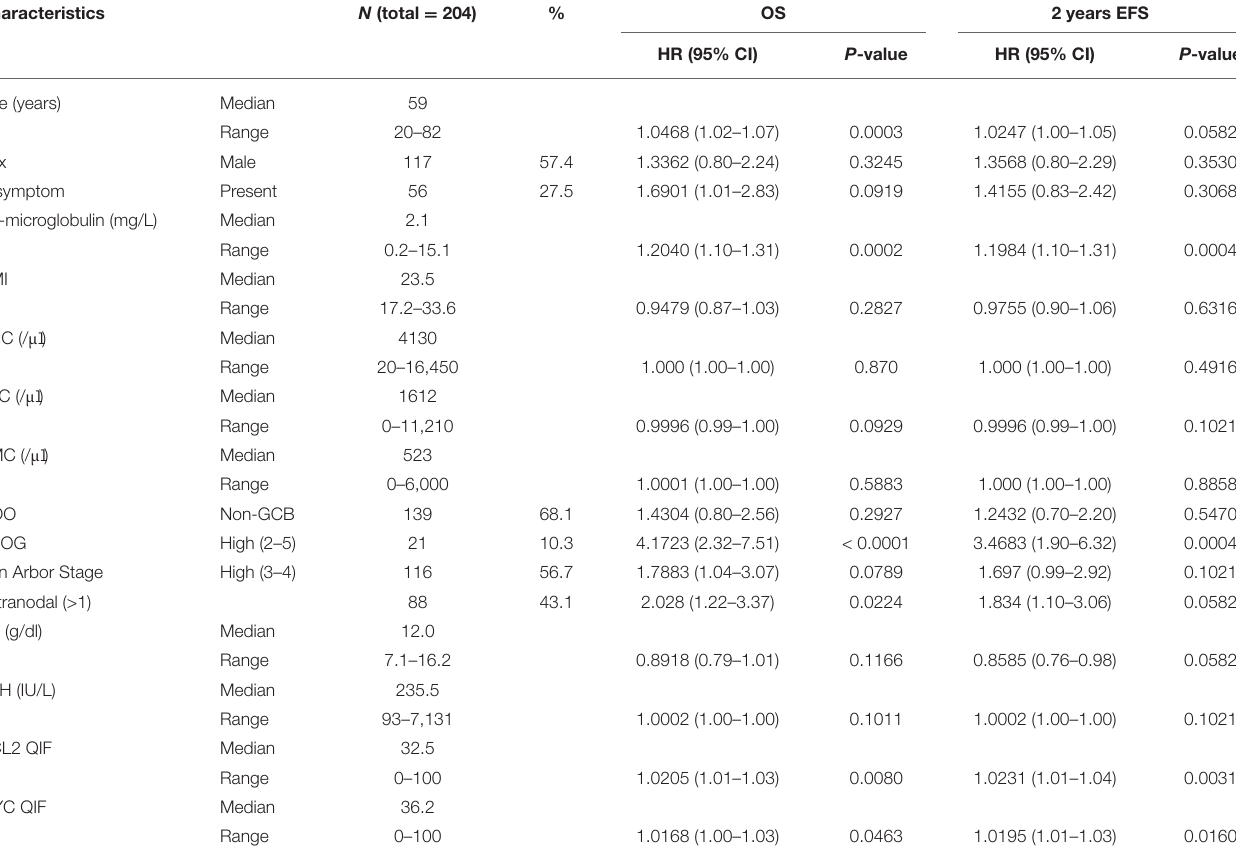
TABLE 1 | Baseline characteristics of